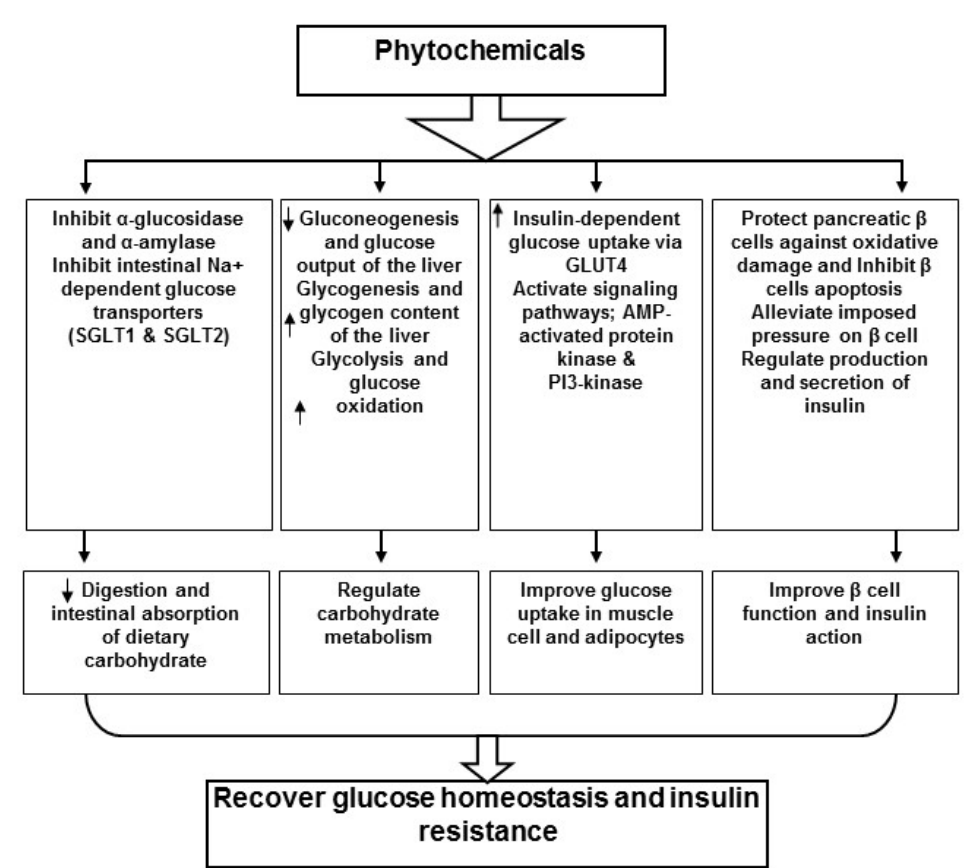
Figure 2. The hypoglycemic effects of phytochemicals are chiefly ascribed to lower the uptake of carbohydrates in intestine affecting the glucose metabolism by applying an alteration in the enzyme activities, β -cell function betterment and insulin action improvement, insulin release initiation and antioxidant as well as anti-inflammatory characteristic of these components. SGLT: Sodium-Glucose Linked Transporter.